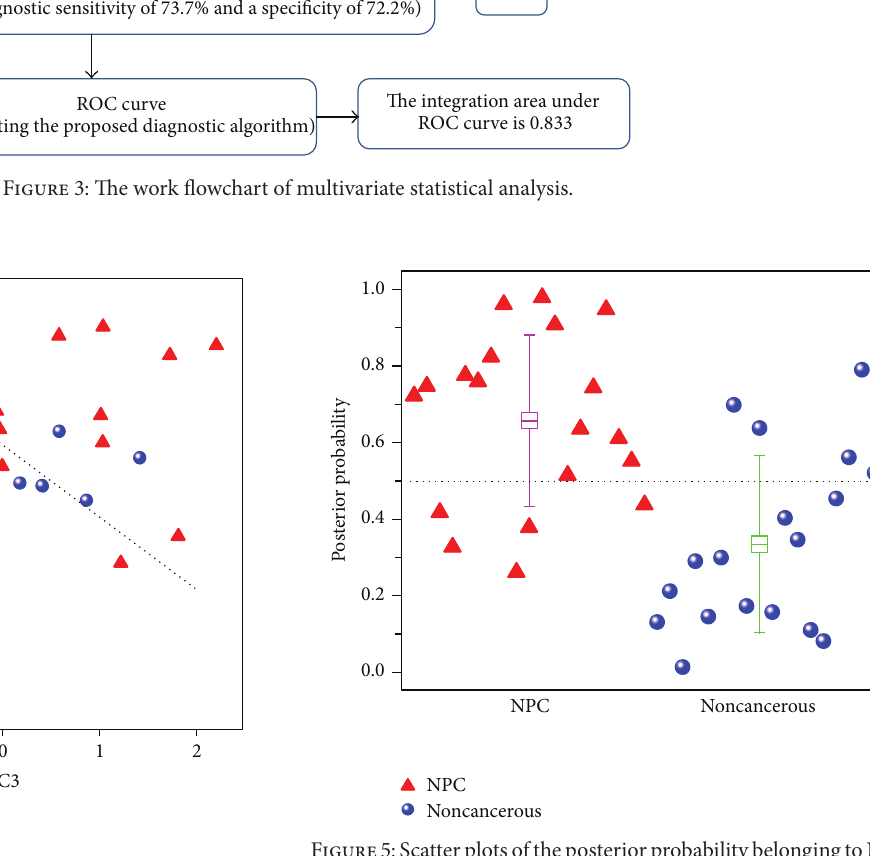
Figure5:ScatterplotsoftheposteriorprobabilitybelongingtoNPC and nasopharyngeal noncancerous subjects ( 󳵳 —NPC group; e — noncancerous group), generated from PCA-LDA diagnosis algo- rithms along with LOOCV method. Error bars represent the mean and standard deviation of NPC (magenta) and nasopharyngeal noncancerous(green) exvivo tissueposteriorprobability.Thedotted lines represented the sensitivities and specificities for separating NPC from nasopharyngeal noncancerous